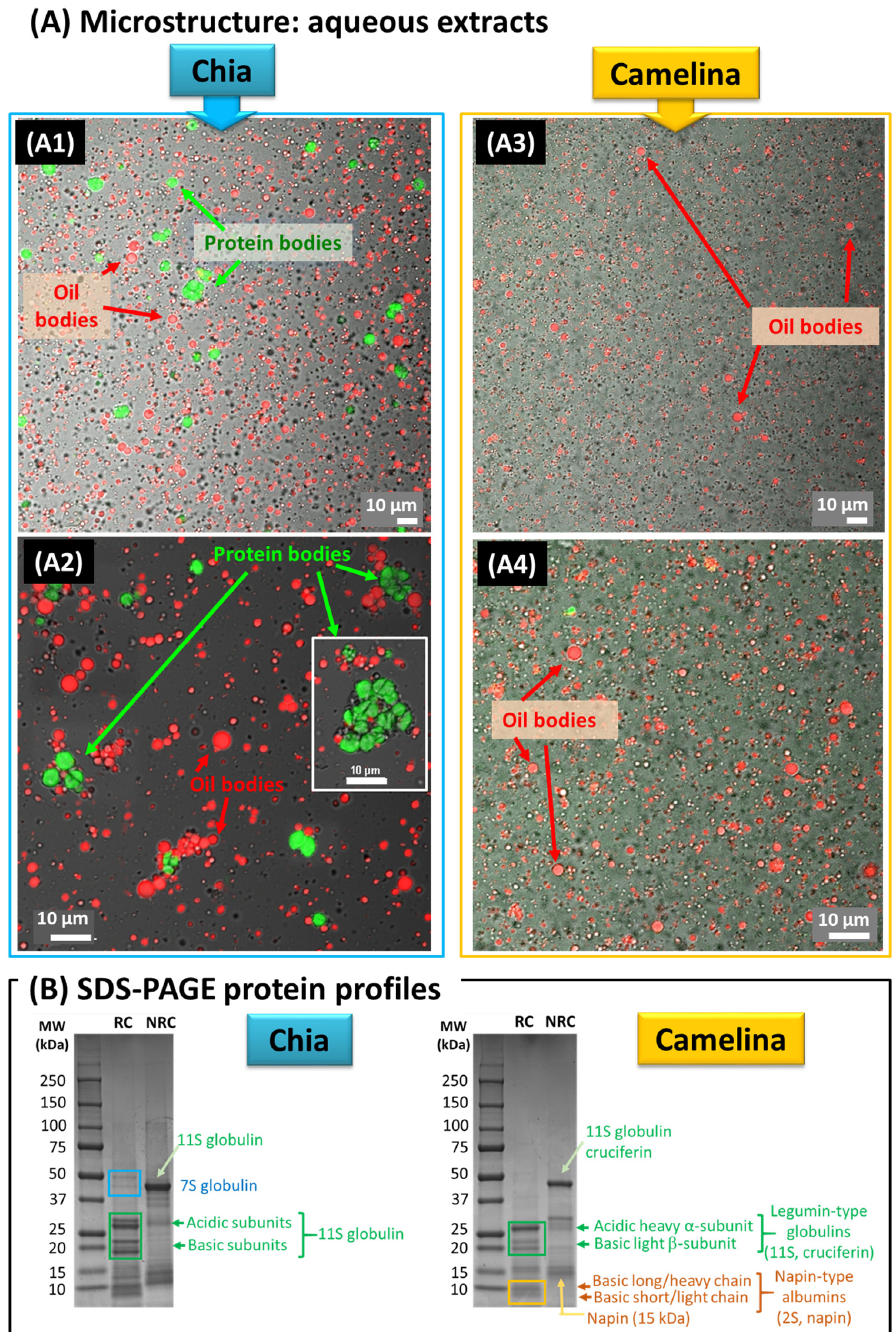
Figure 2. Microstructure of the aqueous extracts obtained from chia and camelina seeds. ( A ) Confo- cal laser scanning microscopy (CLSM) combined with DIC images of the chia seed (left; ( A1 , A2 )) and camelina seed (right; ( A3 , A4 )) aqueous extracts showing the dispersion of oil bodies and proteins (OBs: red colour, Nile Red fluorescent dye; protein bodies: green colour, Fast Green FCF fluo- rescent dye); ( B ) SDS-PAGE protein profiles of the chia seed and camelina seed aqueous extracts. Abbreviations: MW: molecular weight; NR: non-reducing conditions; RC: reducing conditions.